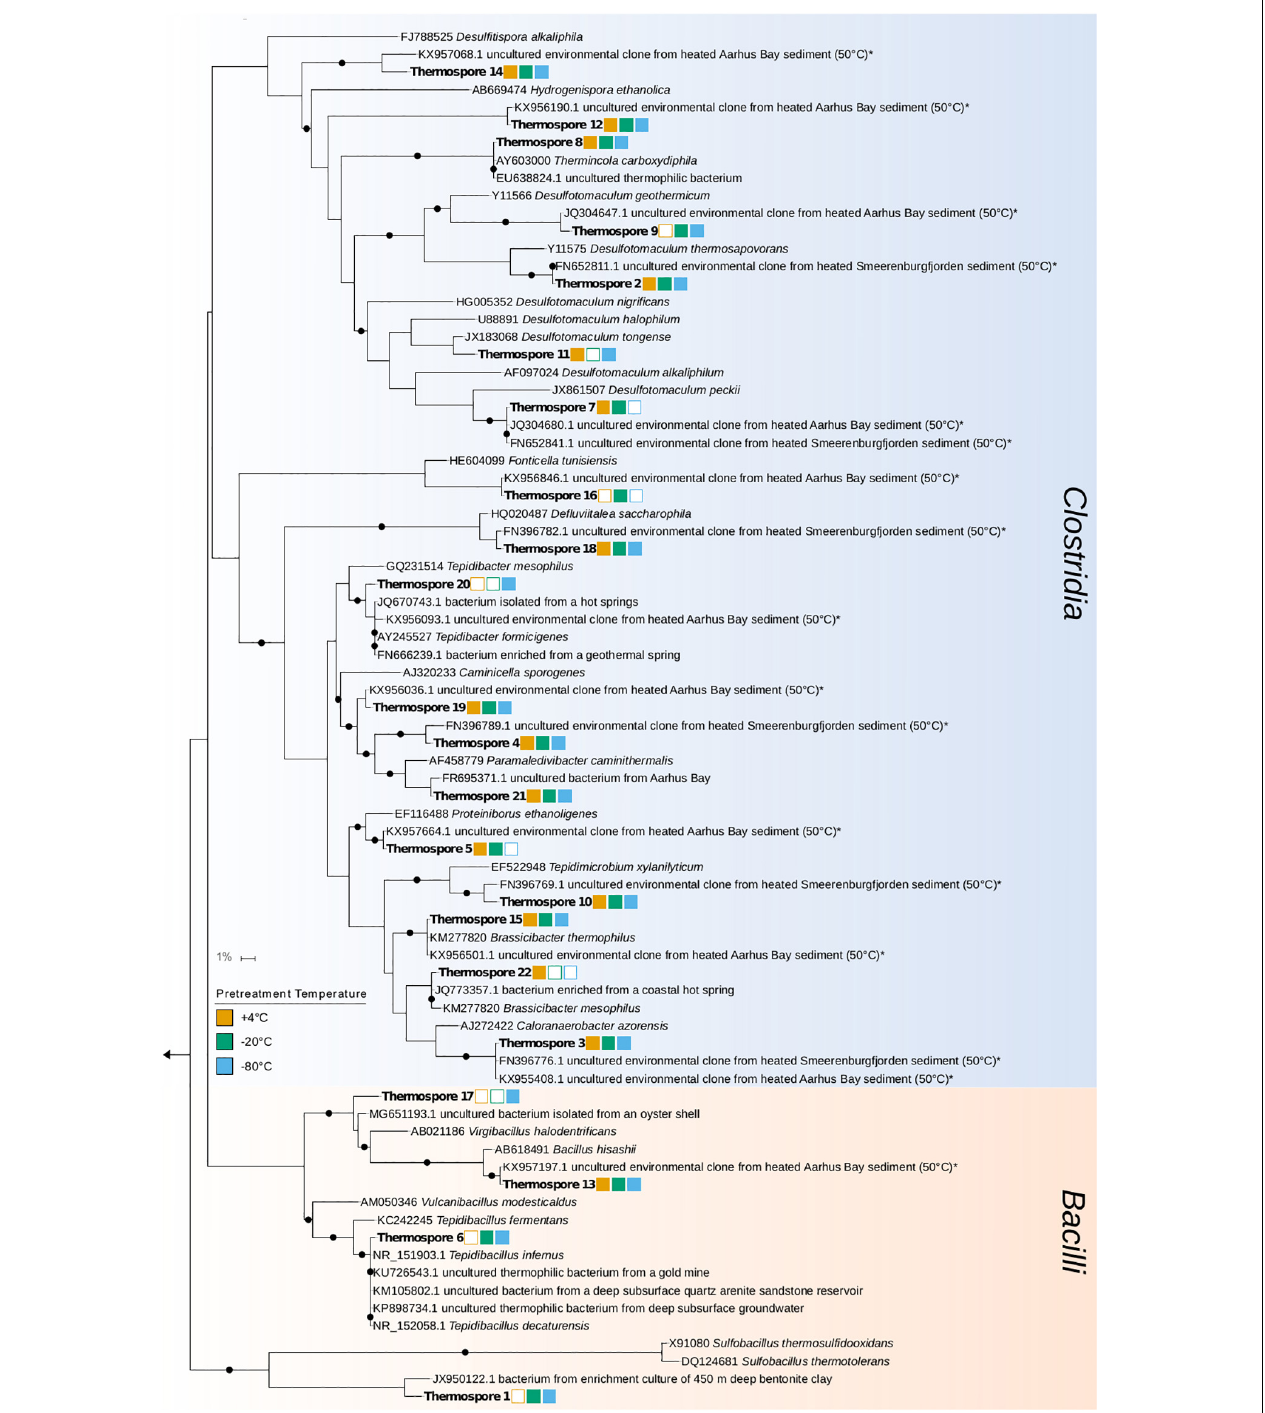
FIGURE 6 | Phylogenetic tree of annotated 16S rRNA gene sequences from 22 thermospore OTUs identified in this study (in bold) and their closest cultured and uncultured relatives (determined by BLASTn searching; Johnson et al., 2008). Percent identity for uncultured relatives is between 98 and 100%, and for cultured relatives is between 87 and 100%. Uncultured relatives identified in similar sediment heating experiments are indicated by an asterisk. Bootstrap values greater than 80% after 100 re-samplings are indicated by black circles at the nodes. Squares to the right of the thermospore OTUs indicate the pretreatments prior to the +50 ◦ C incubations in which that thermospore was identified (an empty square indicates that the OTU was not identified in any replicates in that pretreatment). The scale bar indicates 1% sequence divergence as inferred by PhyML.